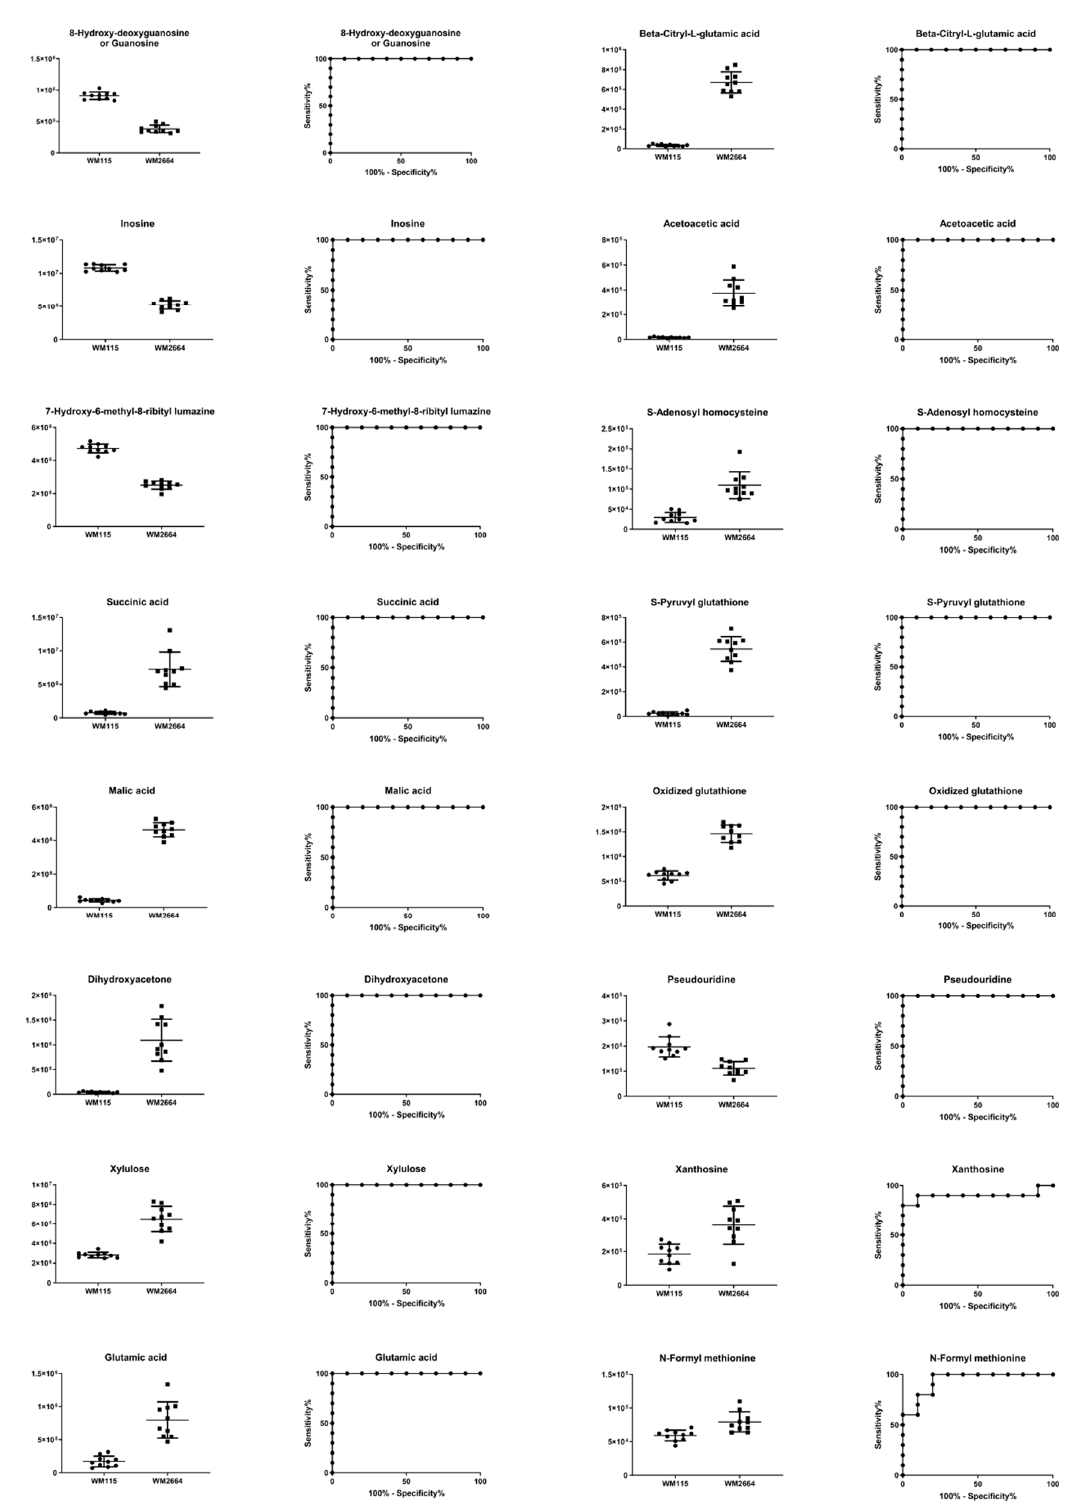
Figure 10. Boxplots and ROC curves, for identified MS features, in negative ion mode, with AUC > 0.8.